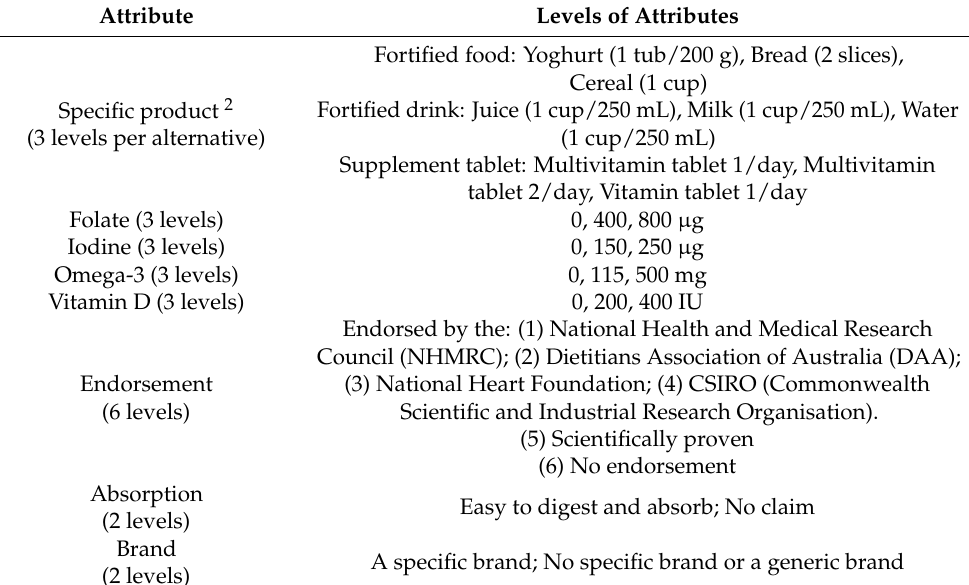
Table 1. Attributes and levels included in discrete choice experiment; health benefits of nutrients shown in the information treatments 1